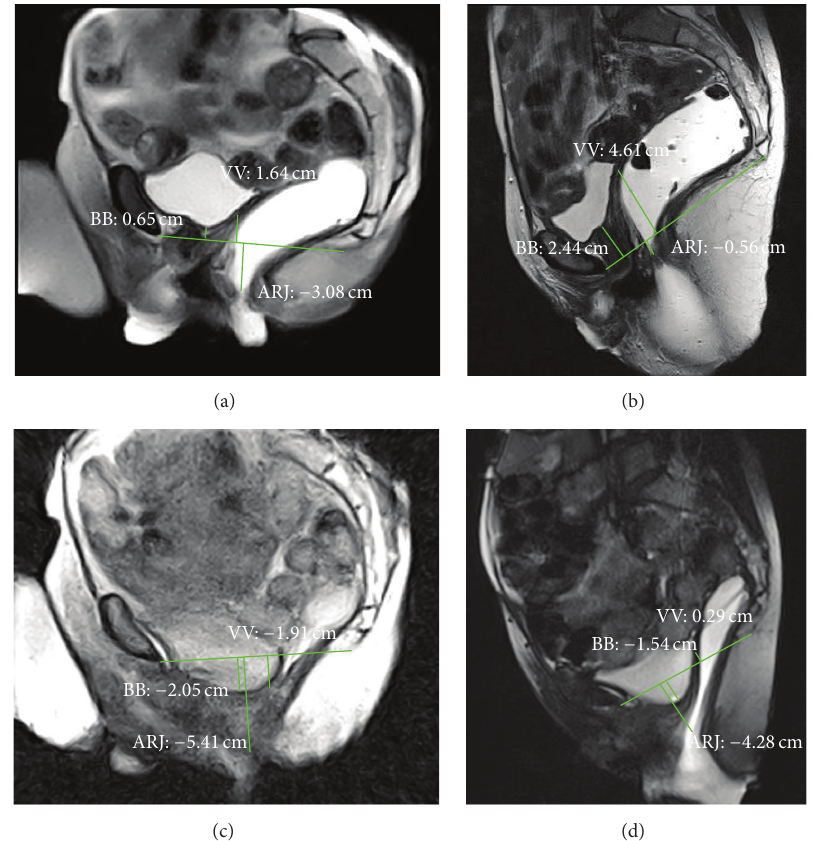
Figure 3: MR Defecography. Rest phase in sitting (a) and supine (b) position. Evacuation phase in sitting (c) and supine (d) position. The pathological fixed descent was detected only in sitting position in rest phase (a). In evacuation phase, a cystocele and a vaginal vault prolapse became evident (c), and the MR examination in supine position overestimates the dynamic descent, nonpathological in (a) and (c) and pathological in (b) and (d). BB: bladder base; VV: vaginal vault; ARJ: anorectal